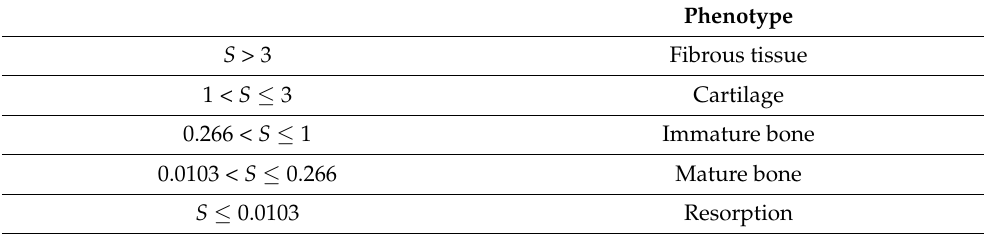
Table A1. Tissue phenotypes corresponded to S